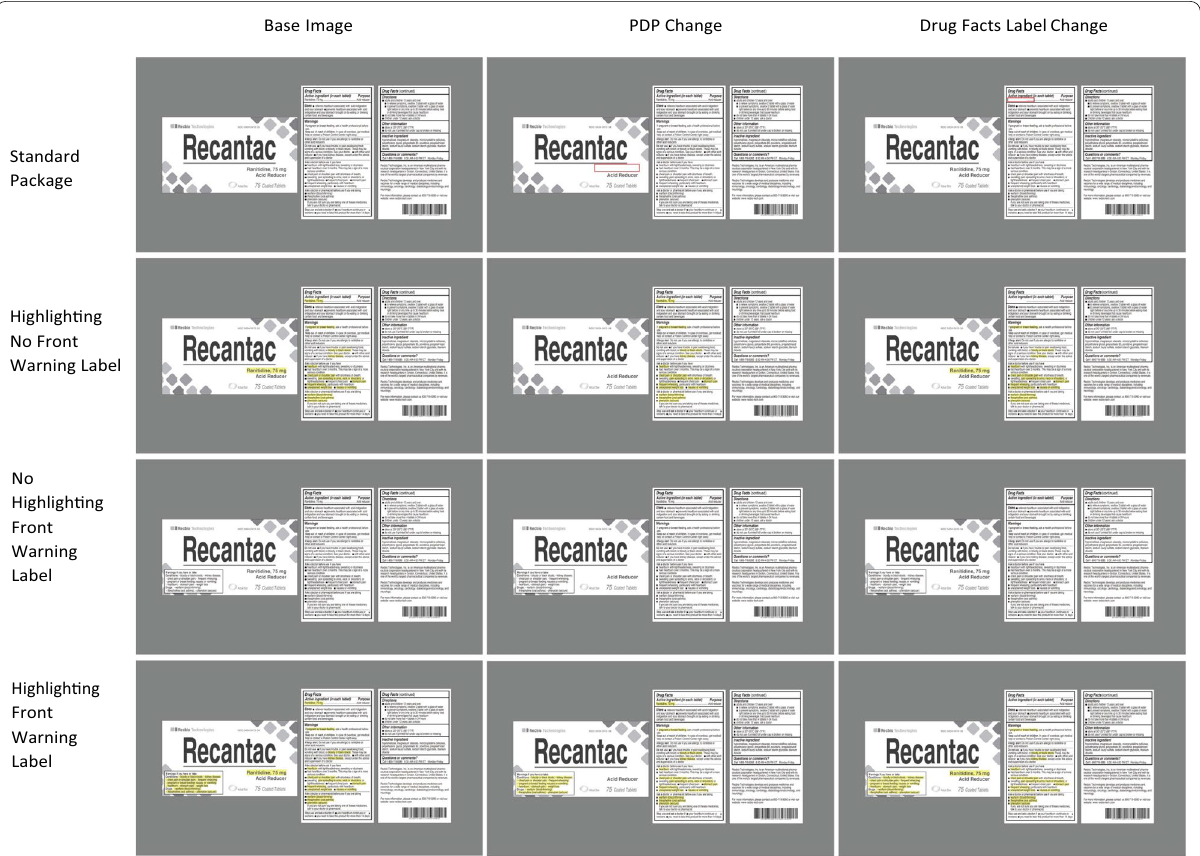
Fig. 3 Examples of the eight active ingredient changes. The left column depicts the complete label for the 4 label treatments. The middle depicts the altered images with a change to the PDP. The right depicts the altered images with a change to the active ingredient in the Drug Facts Label. The red squares in the top row are to illustrate the change location and did not